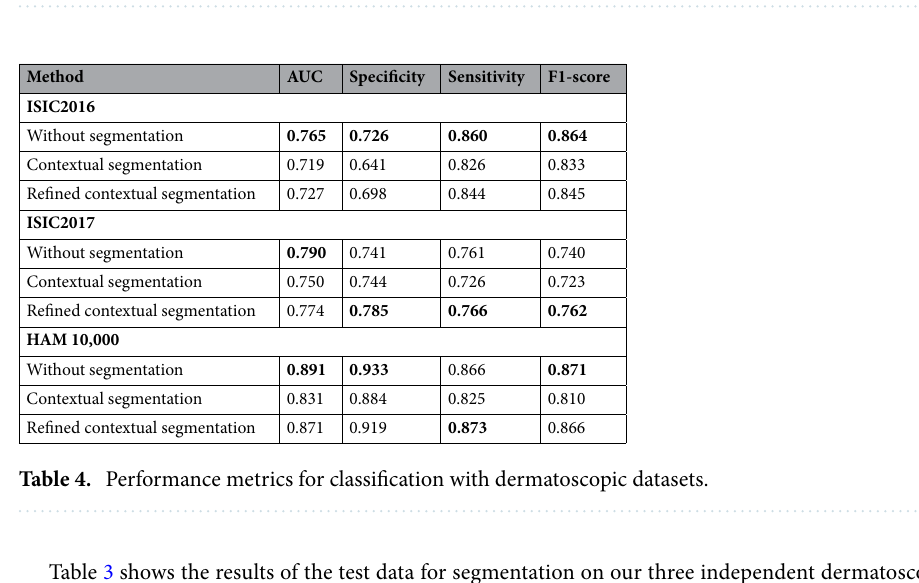
Table 3. Performance metrics for segmentation with dermatoscopic datasets.